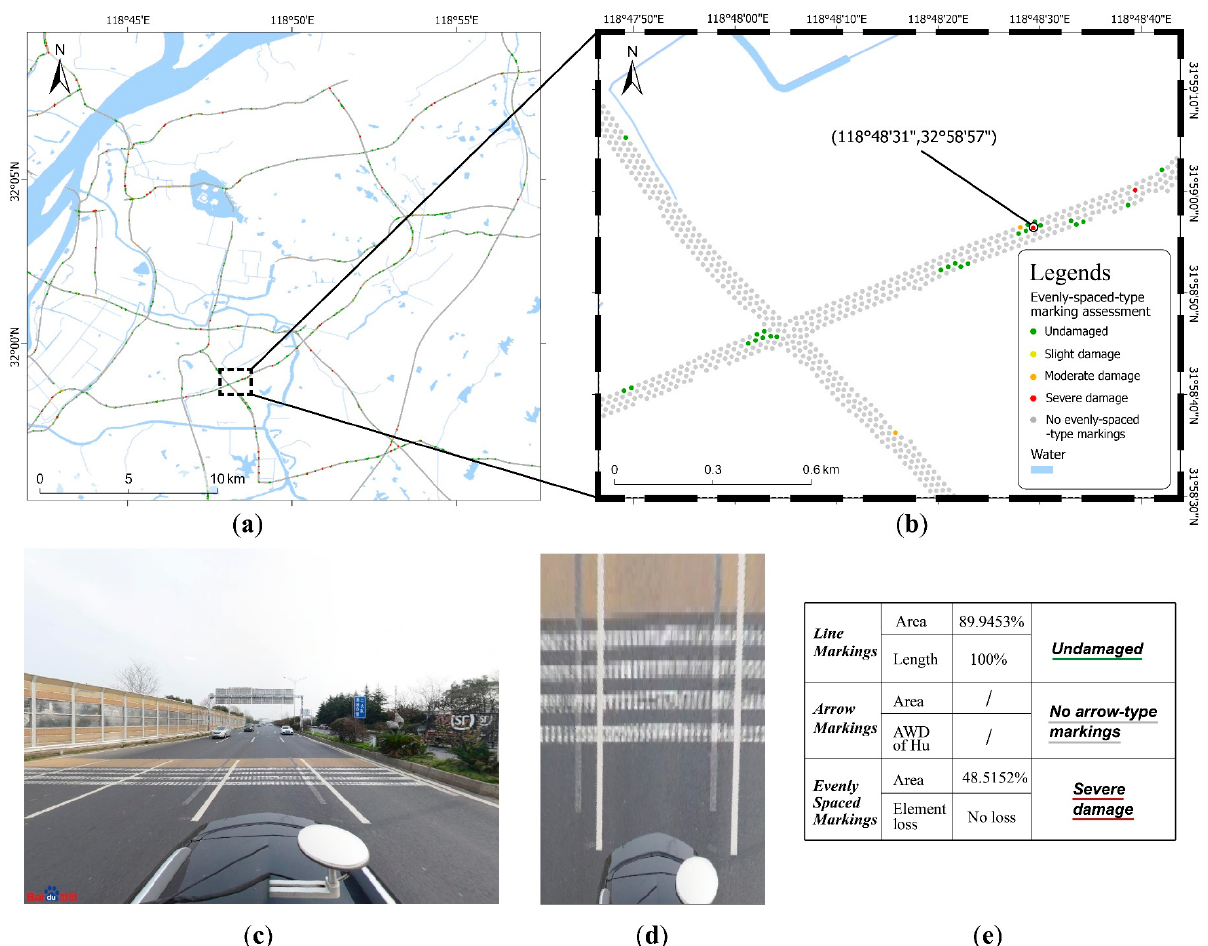
Figure 14. An example of pavement markings on the portion connecting the ordinary road to the viaduct. ( a ) Approximate location in Nanjing city, ( b ) explicit position of the images captured at the sampling point, ( c ) original street-view image of the sampling point, ( d ) converted birds’-eye view of the panel ( c ); ( e ) assessment of pavement markings at the sampling point.